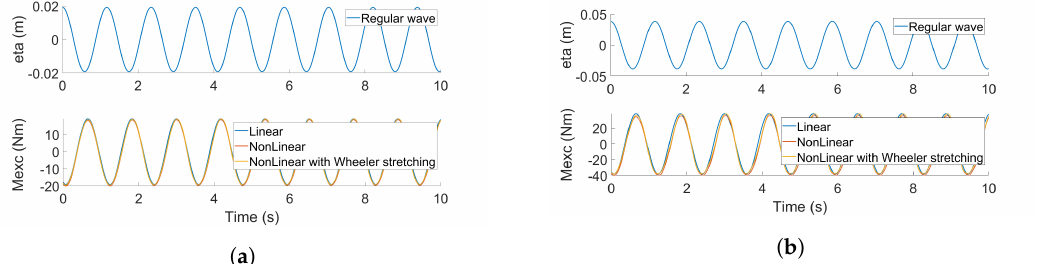
Figure 9. Numerical results of setup of WEC only from linear theory, non-linear model with instantaneous body position, and non-linear model with instantaneous body position with Wheeler stretching. ( a ) Regular wave with target wave height used in experiments (R02). ( b ) Regular wave with a larger wave height (same wave period as R02) that would allow the WEC to rotate within the recommended motion interval of the